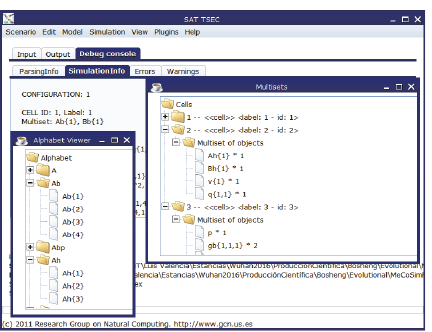
Figure 8: An example of simulation information in a